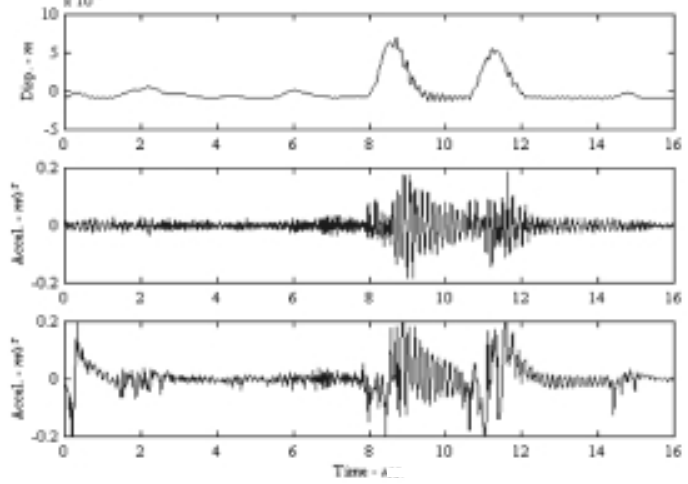
Fig. 6. Comparison between direct measurement of displacement (upper plot) by laser vibrometer, its second derivative (middle plot) and accelerometer signal (lower